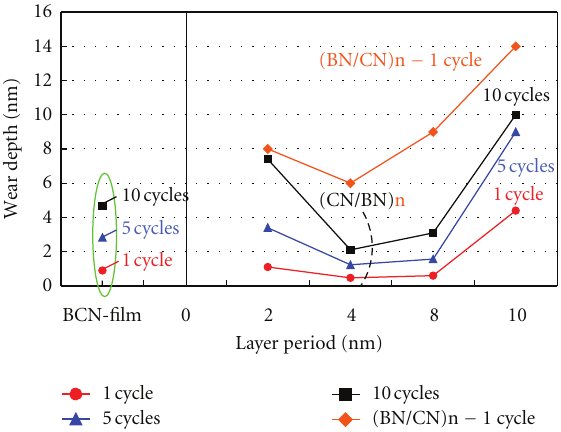
Figure 11: Dependence of nanowear on layer period of multilayer films obtained at a load of 10 µ N from 1 to 10 scanning cycles.